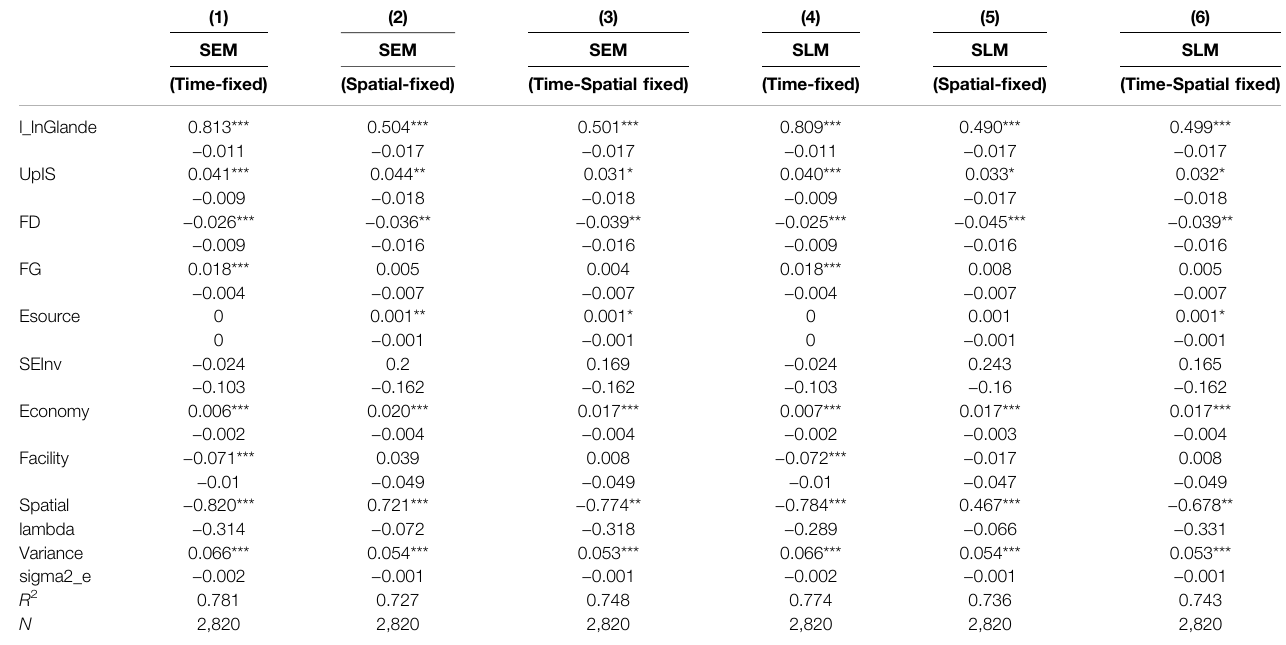
TABLE 8 | Estima ted results of SLM and